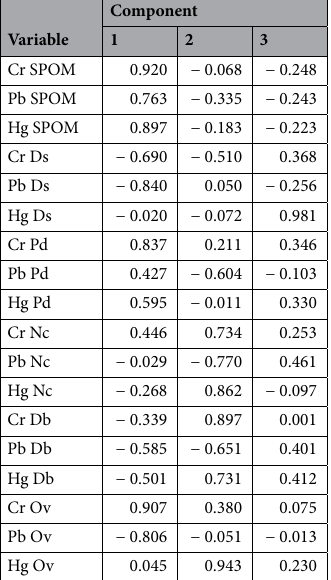
Table 2. PCA component matrix. Values represent the contribution of each variable to PC 1 and PC 2. SPOM Suspended Particulate Organic Matter, Ds Desmarestia spp., Pd Palmaria decipiens , Nc Nacella concinna , Db Diplasterias brucei , Ov Odontaster validus